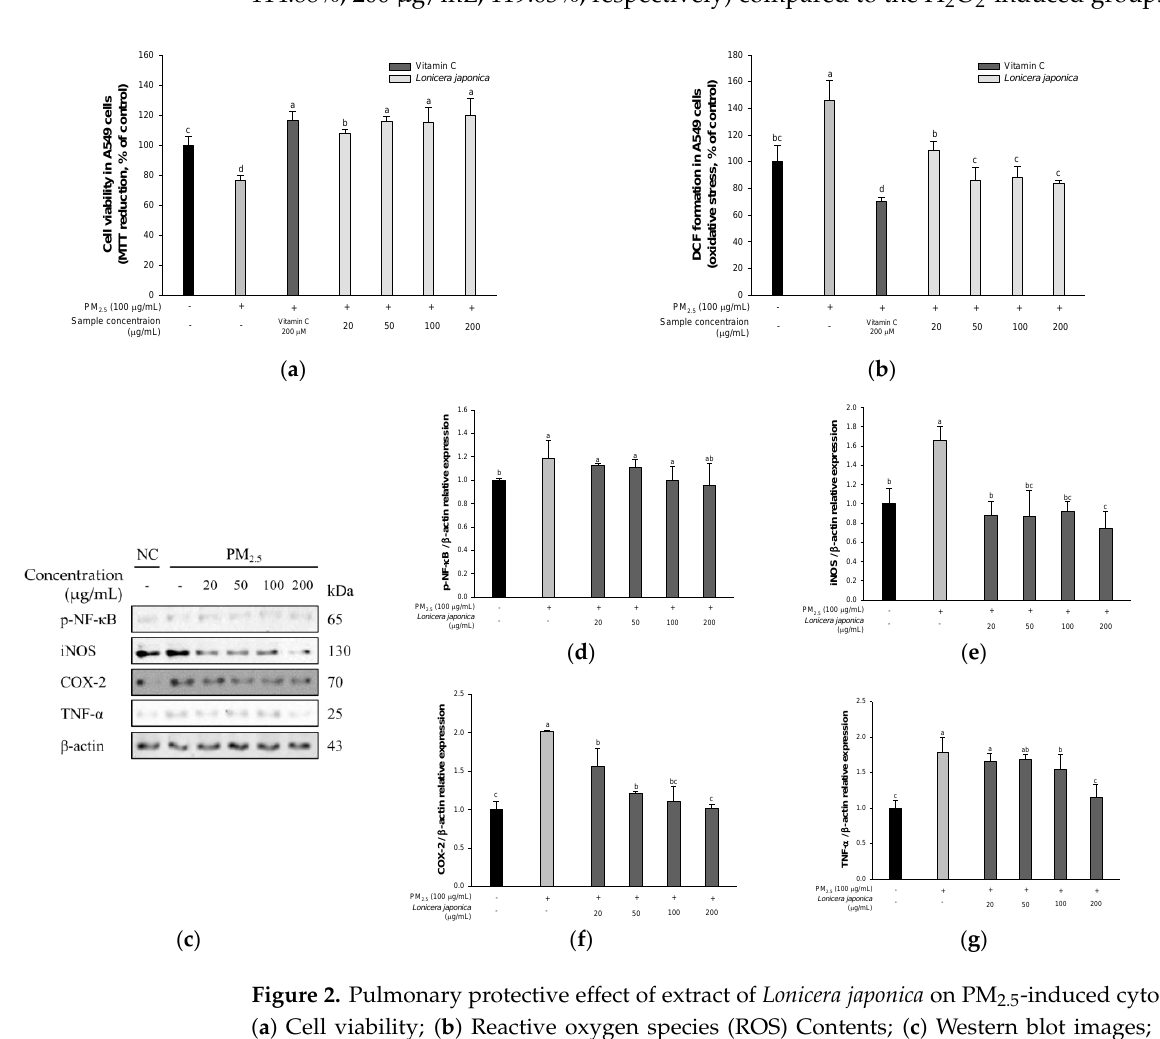
Figure 2. Pulmonary protective effect of extract of Lonicera japonica on PM 2.5 -induced cytotoxicity. ( a ) Cell viability; ( b ) Reactive oxygen species (ROS) Contents; ( c ) Western blot images; Protein expression levels of p-NF-κB ( d ), iNOS ( e ), COX-2 ( f ), and TNF-α ( g ). Results shown are mean ± SD ( n = 3). Data were statistically represented at p < 0.05, and different lowercase letters indicate statistical significance.